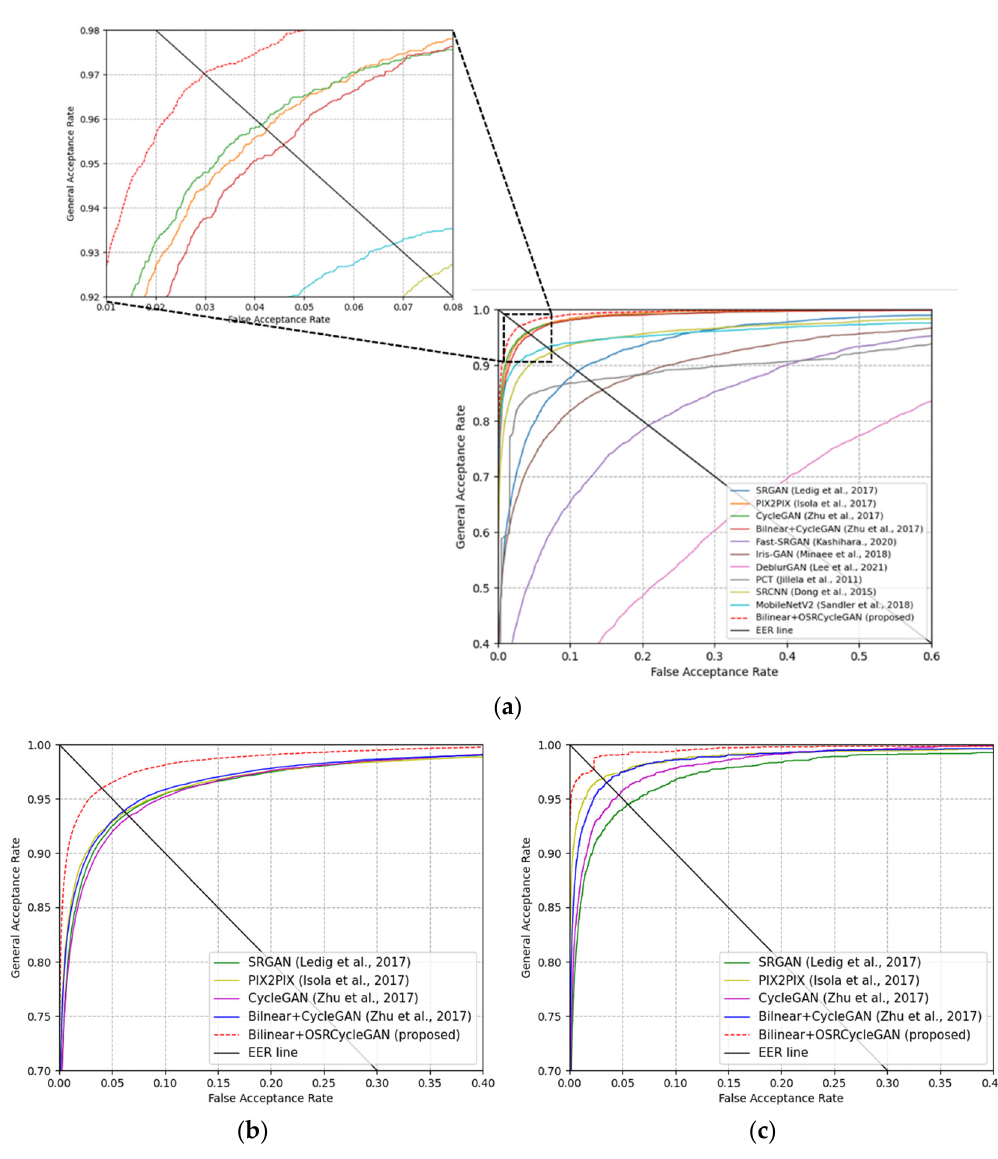
Figure 6. ROC curves of ocular recognition by the proposed method and state-of-the-art methods with ( a ) CASIA-Iris-Distance, ( b ) CASIA-Iris-Lamp, and ( c ) IIT Delhi iris database [16,19,50,66,68–72].